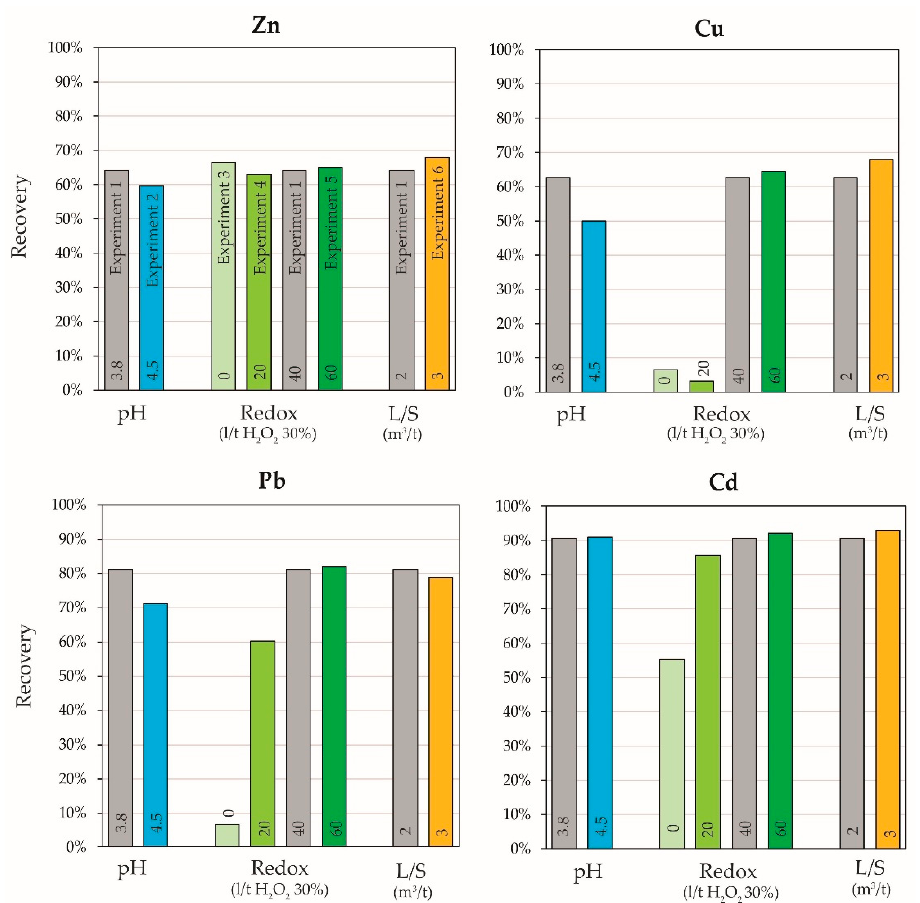
Figure 2. Recoveries of laboratory-scale experiments for Zn, Cu, Pb and Cd to simulate the FLUWA process under different leaching conditions.